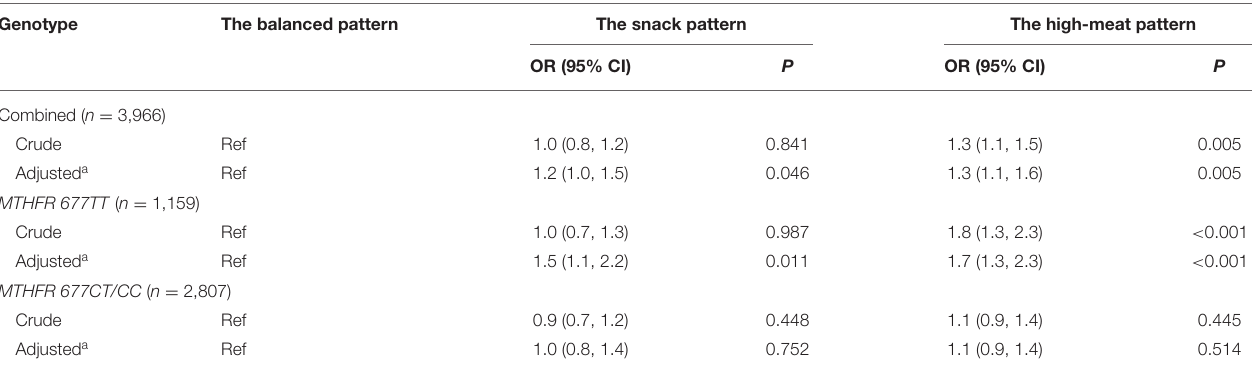
TABLE 2 | Association between dietary patterns and hyperhomocysteinemia. Genotype